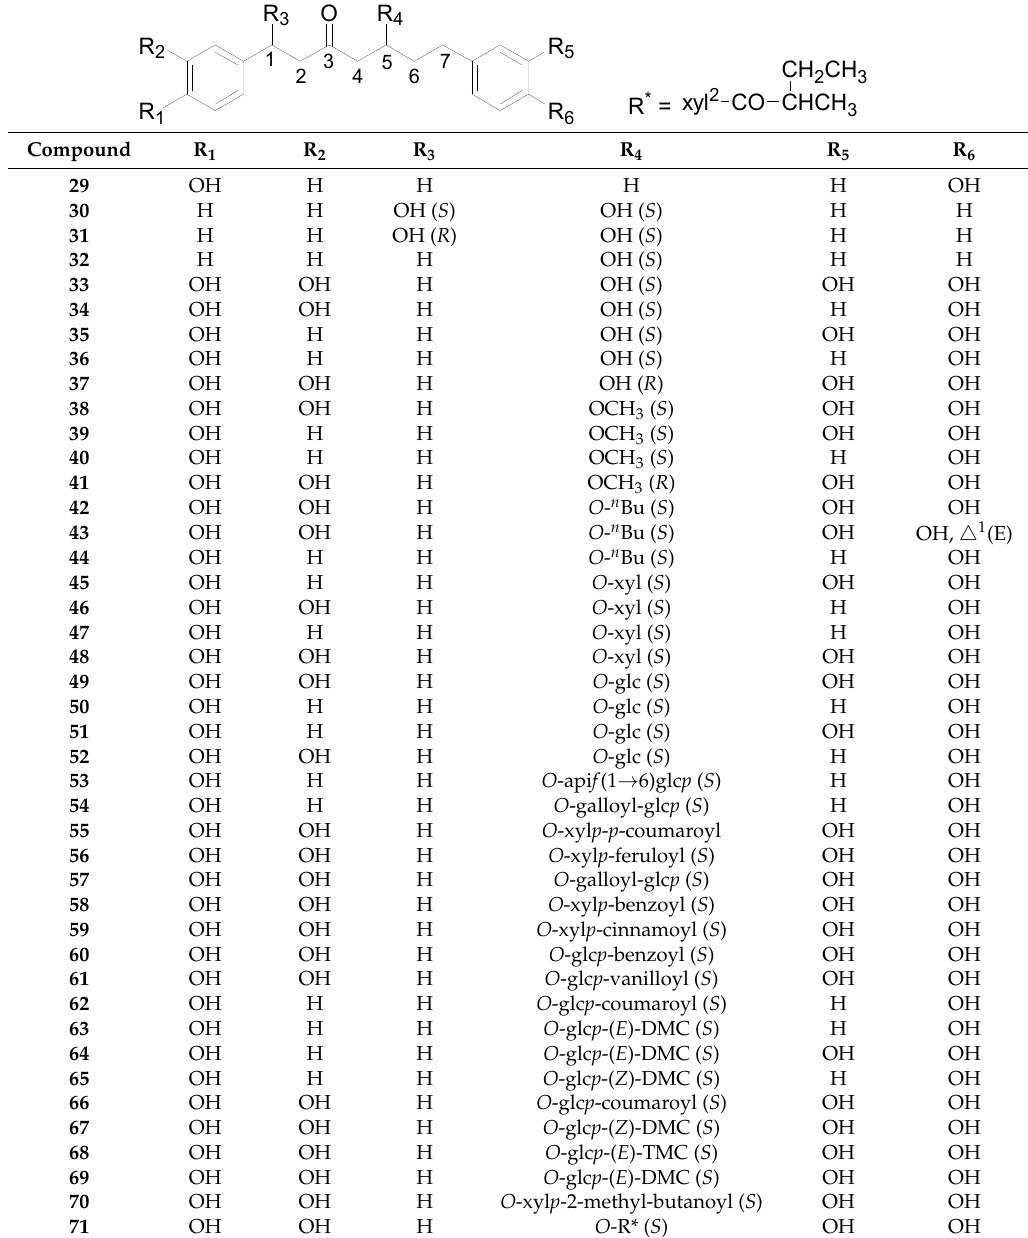
Table 2. Structures of compounds 29 – 71 .